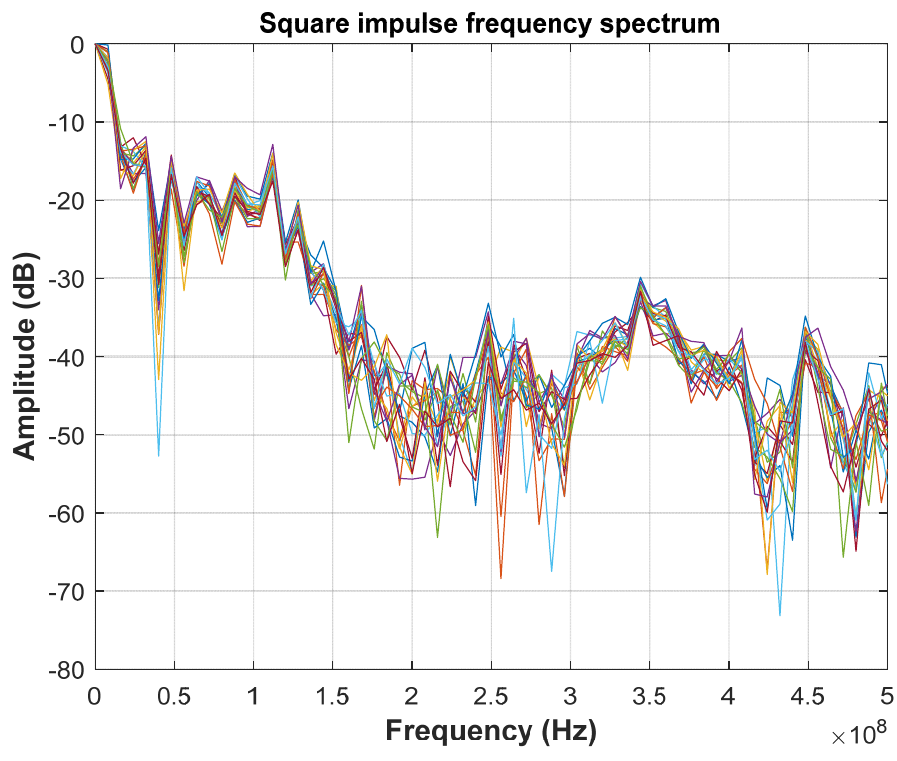
Figure 10. Frequency spectra set of measured signals.